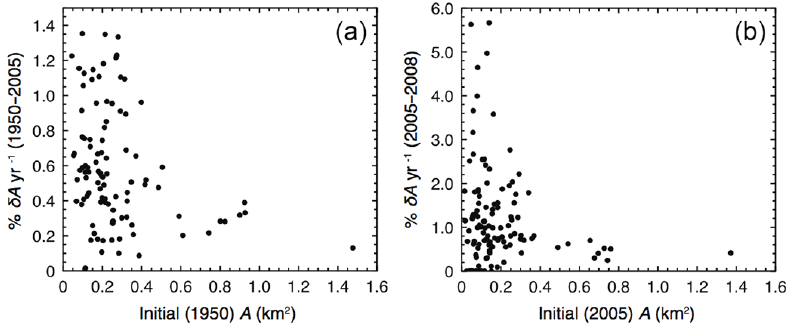
Figure 3. Annually averaged percentage glacier area loss ( δA ) plotted against initial glacier area (in km 2 ), between 1950 and 2005 (a) , and from 2005 to 2008 (b) . Note difference in y axis